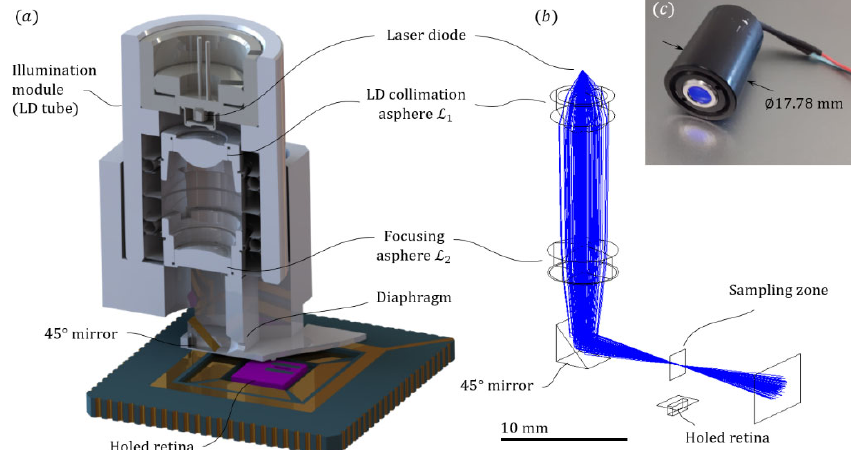
Figure A2. ( a ) 3D view of the full assembly involving the illumination tube, a cloaker and the holed retina (partial cross sectional view). ( b ) RT simulation of the formation of the illumination beam. ( c ) Photography of the illumination tube. The ℒ (cid:2869) , (cid:2870) lens system is designed to properly form a focused beam above the fluidic channel from the bare LD. First, the ℒ (cid:2869) collimation asphere is chosen with a high numer ‐ ical aperture, in order to capture and collimate most of the radiation from the source; then, ℒ (cid:2870) focuses the beam in the aerosol sampling zone.